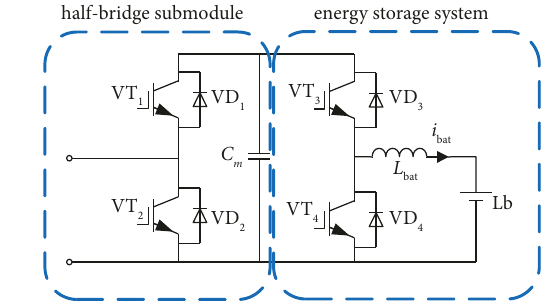
Figure 3: Energy storage submodule.